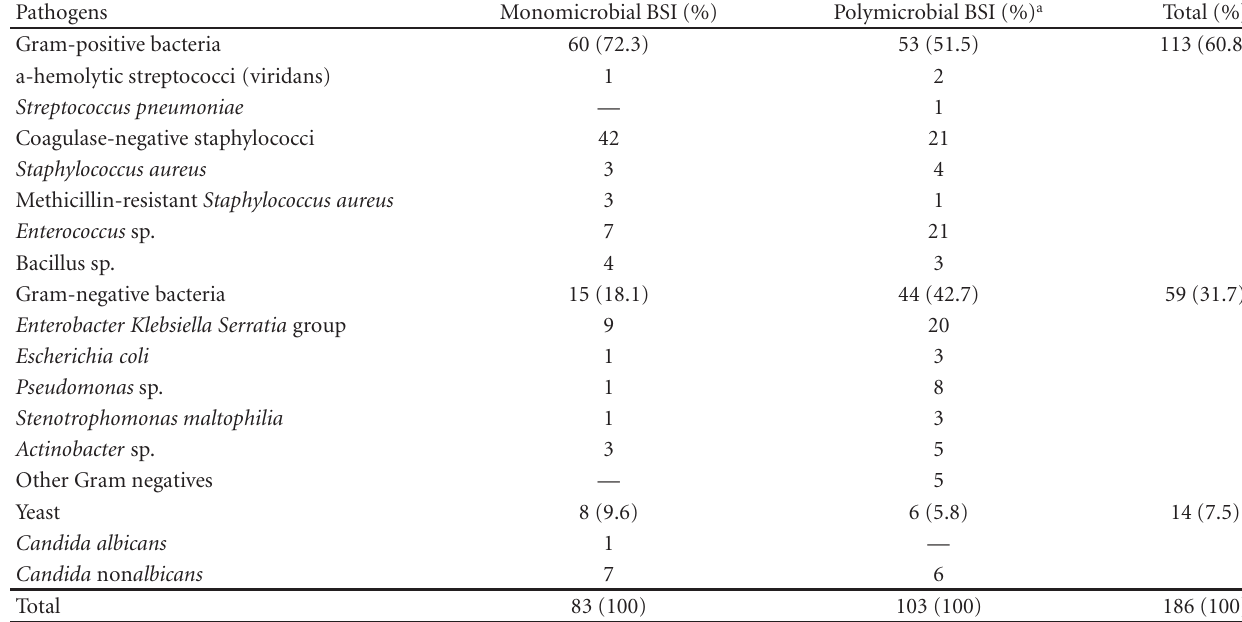
Table 2: Monomicrobial and polymicrobial BSIs.